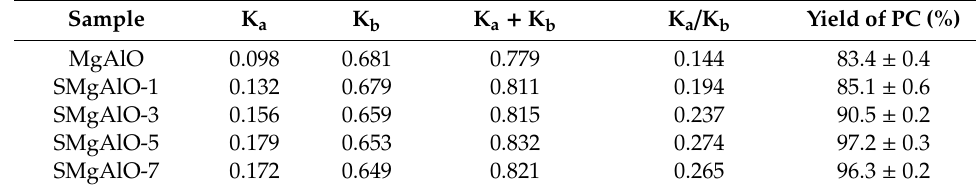
Table 4. Acid-base properties measured by inverse gas chromatography